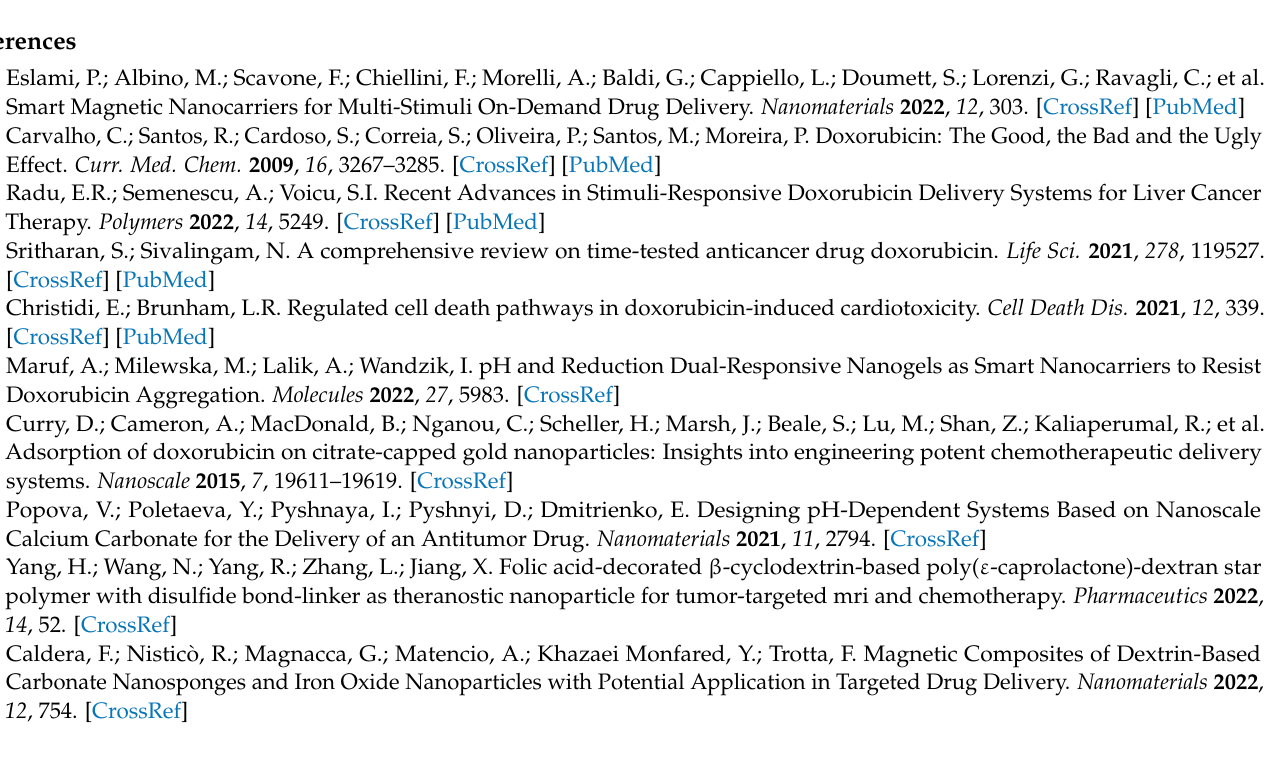
Figure S3: DOX-loaded NC2 time-dependent drug release at various pH values. Figure S4: